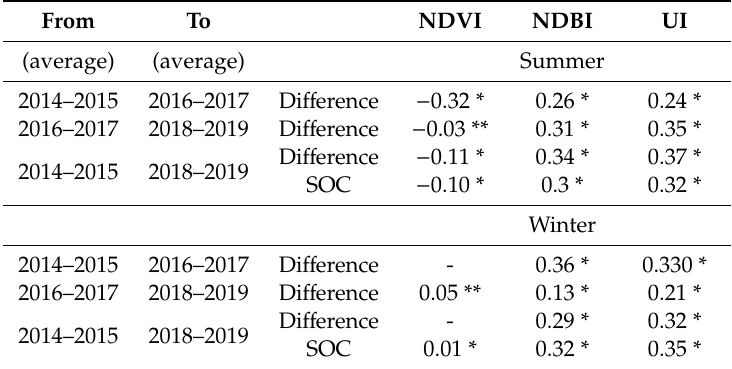
Table 3. Spearman correlation test of the correlation between changes in LST, NDVI, NDBI, and UI: absolute di ff erence (Di ff erence) and SOC between 2014 and 2019.